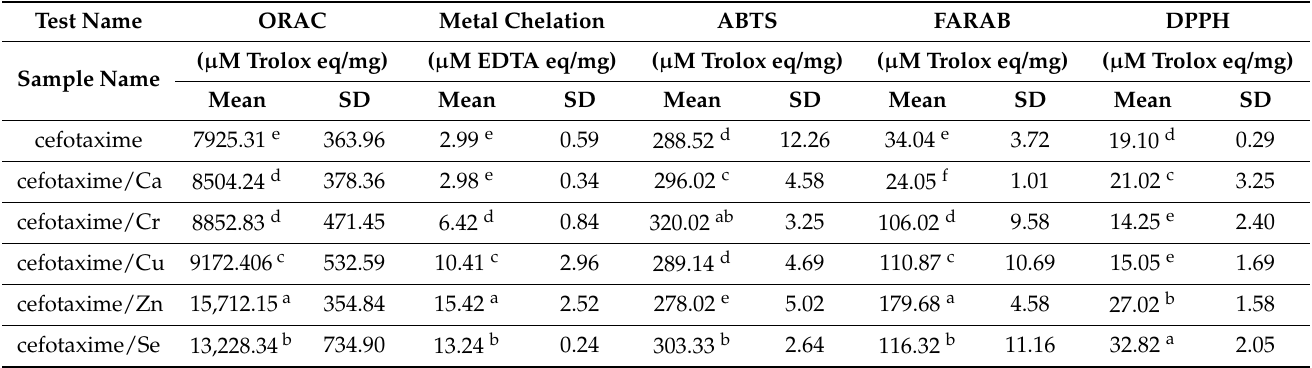
Results are expressed as mean ± SD. Symbols are different alphabetically (a–f) to indicate a significant comparison compared to the control group and other treated groups ( p < 0.05) (Similar letters imply partial or